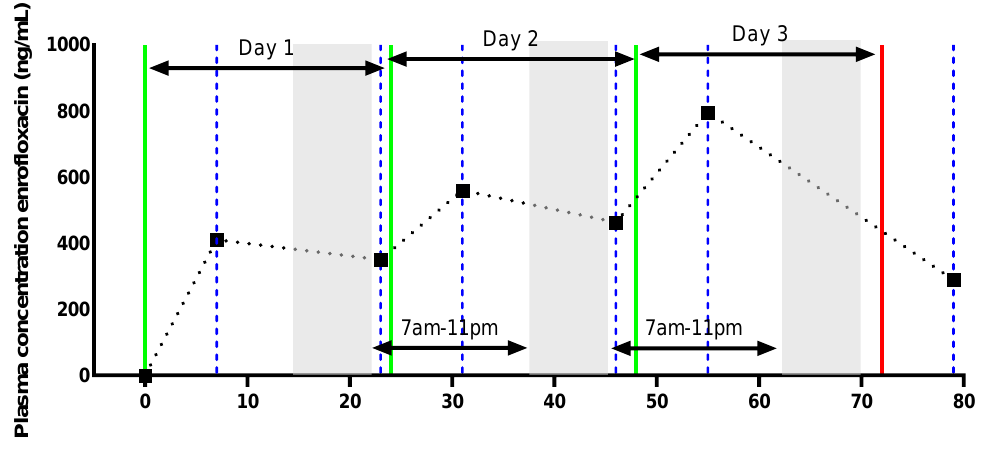
Figure 5. The green lines correspond with the time when enrofloxacin was introduced in the drinking water (9 a.m.) and kept for 24 h. This was done for three consecutive days. The red line indicates the cessation of enrofloxacin administration. The blue dotted lines relate to the six different sample points (7, 23, 31, 46, 55 and 79 h post administration). The grey areas indicate the periods that the light in the stable was turned off (scotoperiod, 11 p.m. to 7 a.m.), and the white areas correspond to the photoperiod. The black dotted line is an example of a PK profile of a representative broiler dosed at 10 mg/kg/24 h.